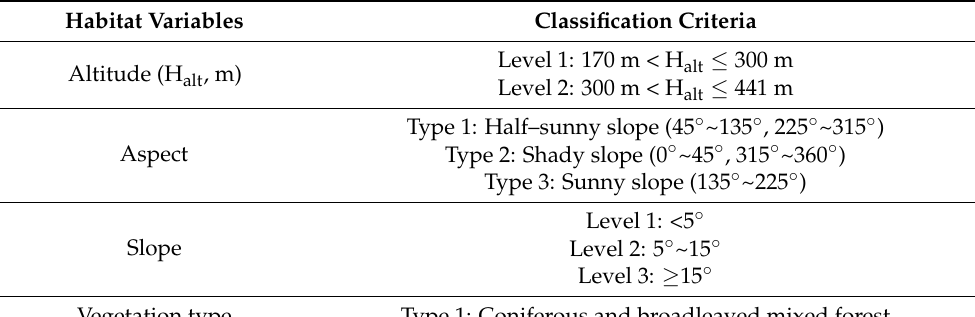
Table 1. Classification criteria of habitat variables for Asiatic black bear and brown bear in Taipinggou National Nature Reserve, Heilongjiang Province, China,